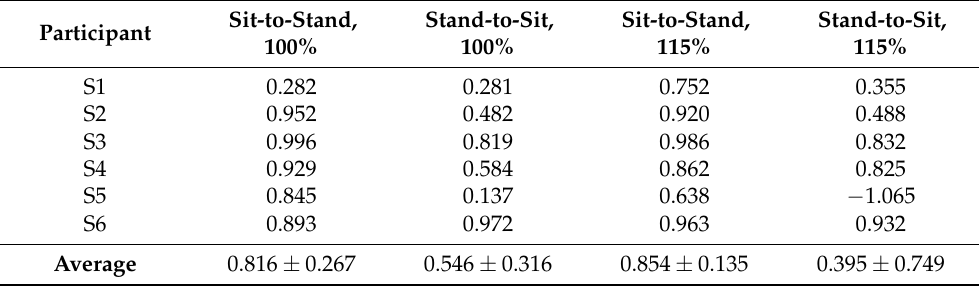
Table 5. R 2 values for different stroke participants for sit-to-stand and stand-to-sit actions at different seat heights, using k = 3 and age and BMI as k − NN